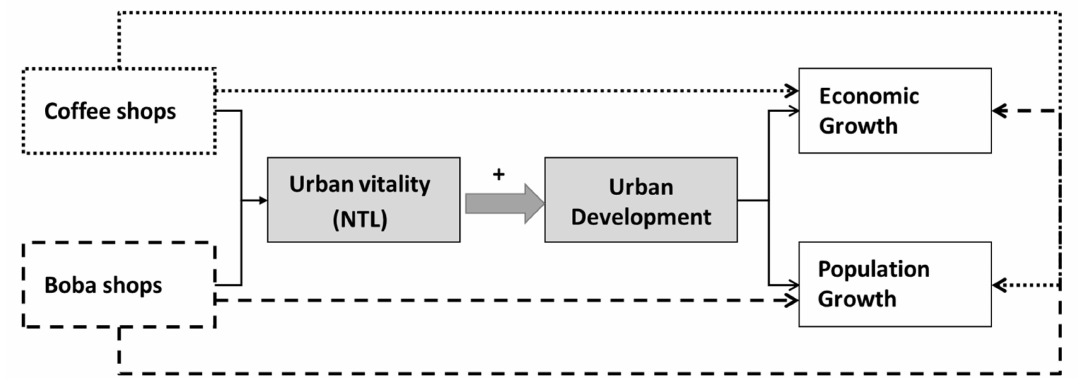
Figure 1. Research framework.